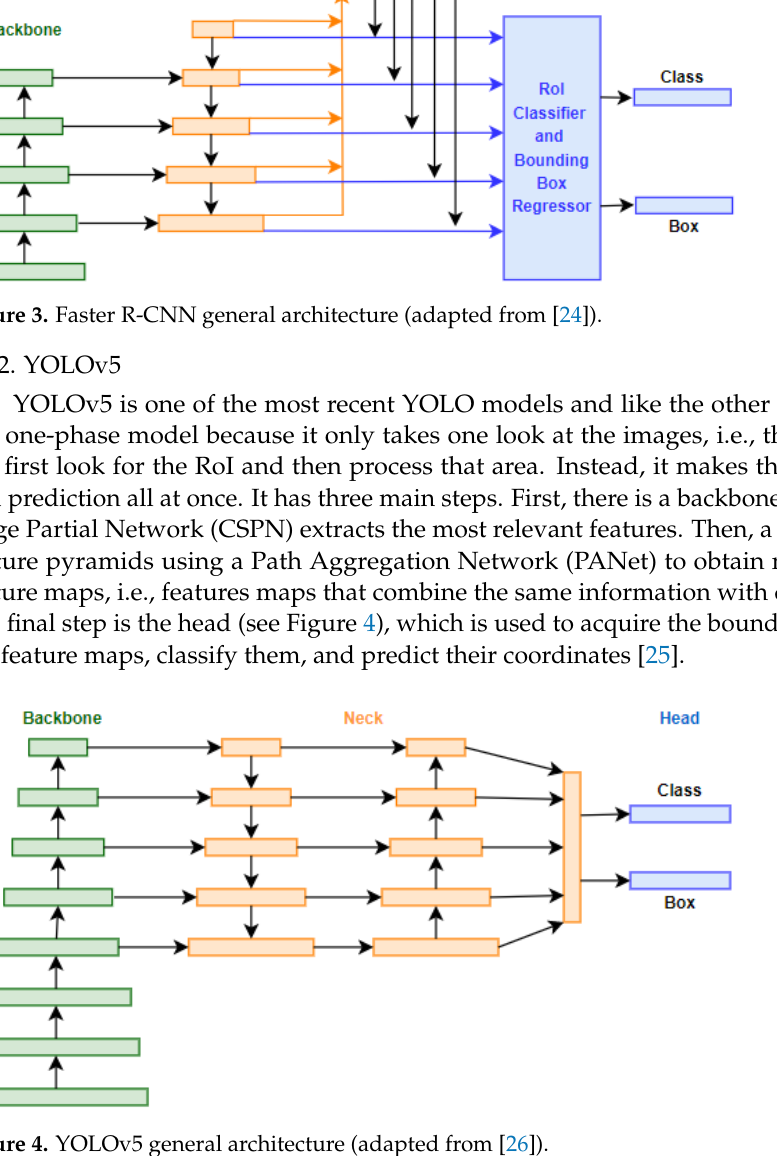
Figure 4. YOLOv5 general architecture (adapted from